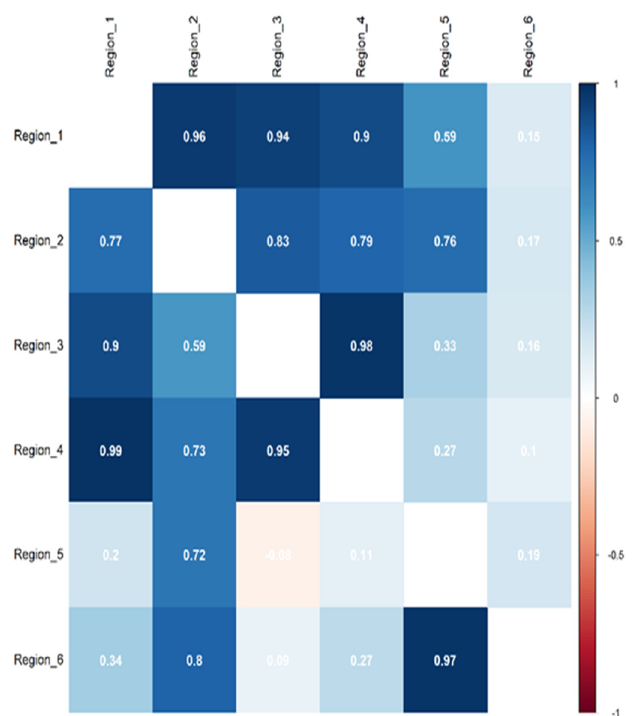
Figure 2. Spearman’s rank correlation coefficients of triticale cultivars’ rankings between all regions in Poland for each crop management (moderate-input crop management (MIM)—upper triangle, high-input crop management (HIM)—lower triangle ).